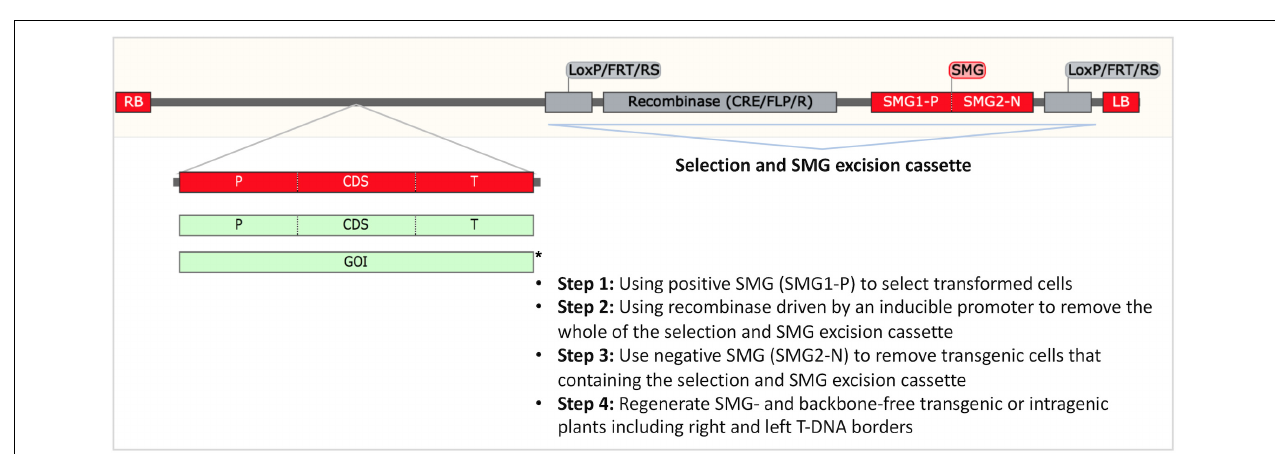
FIGURE 5 | Different approaches for FastTrack breeding – an example for blueberries. (A) Stable gene transformation into elite cultivars for overexpression of flower-promoting genes (e.g., FT , SUPPRESSOR OF OVEREXPRESSION OF CONSTANS 1 , LEAFY , and APETALA1 ) or repression of flower-repressing genes (e.g., TERMINAL FLOWER 1). The early flowering seedlings enable blueberry to skip 2–3 years of juvenile period for each cross. (B) Transgrafting on FT -overexpressing rootstock promotes early flowering of the scion.